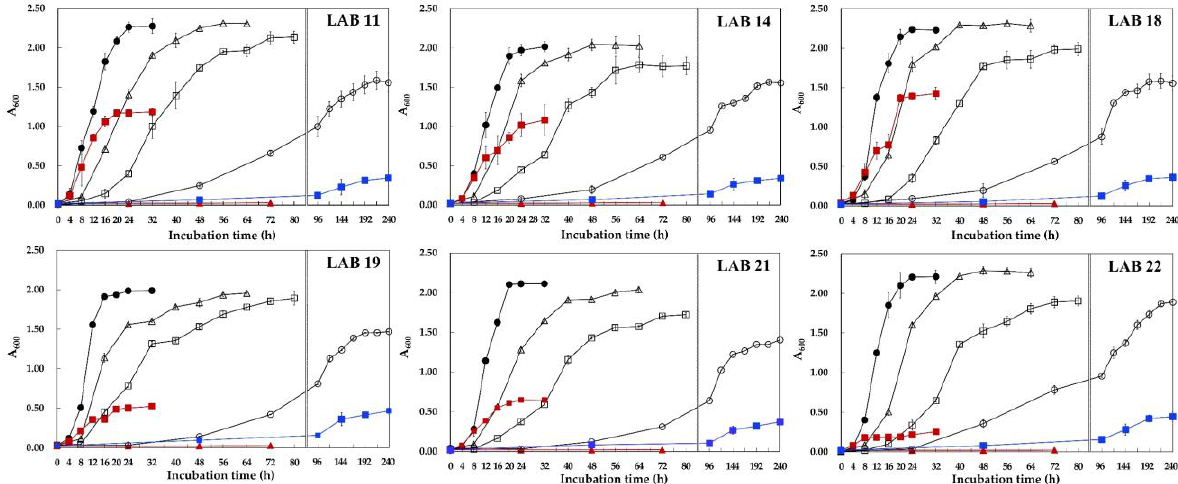
Figure 2. Growth of LAB isolates at different temperatures. LAB isolates were incubated in MRS broth at 0 °C ( ■ ), 5 °C ( ○ ), 10 °C (□), 15 °C ( △ ), 25 °C ( ● ), 30 °C ( ■ ), or 37 °C ( ▲ ) for 0~240 h.